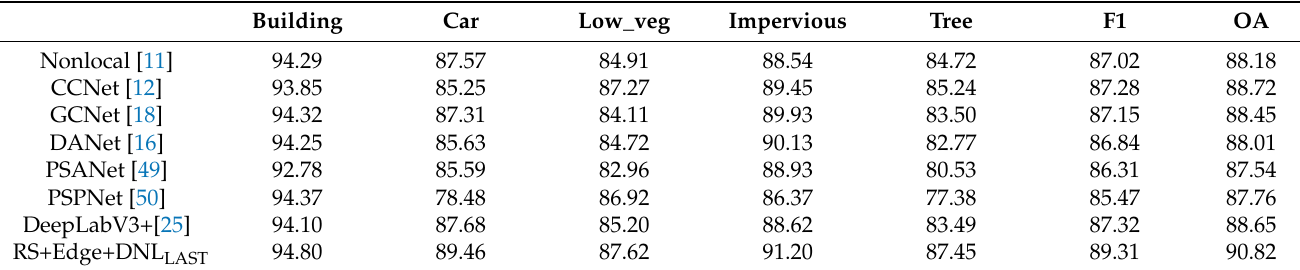
Table 7. Accuracy comparison (%) with state-of-the-art computer vision DCNN models on the Potsdam benchmark with an edge-eroded